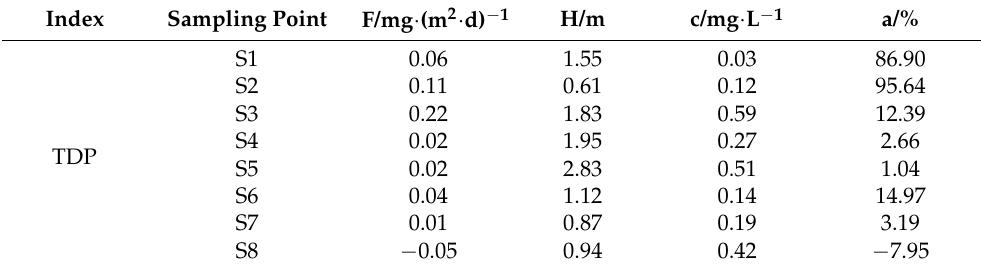
Table 10. Contribution rate of TDP nutrient diffusion at the sediment–water interface to the water